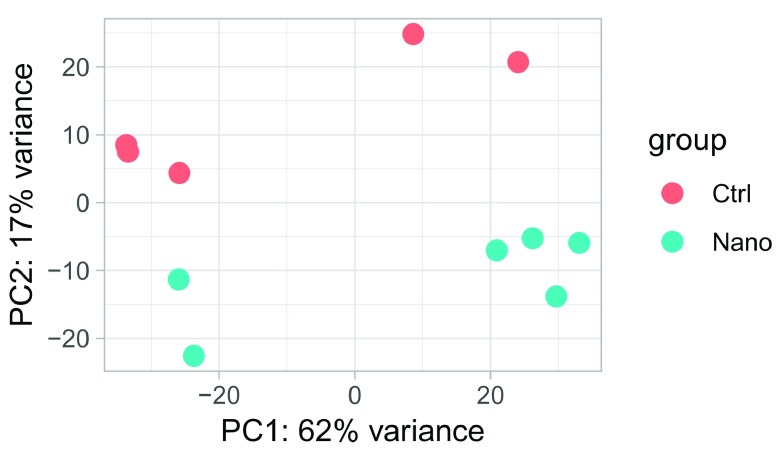
PCA-plot of variance stabilized expression.